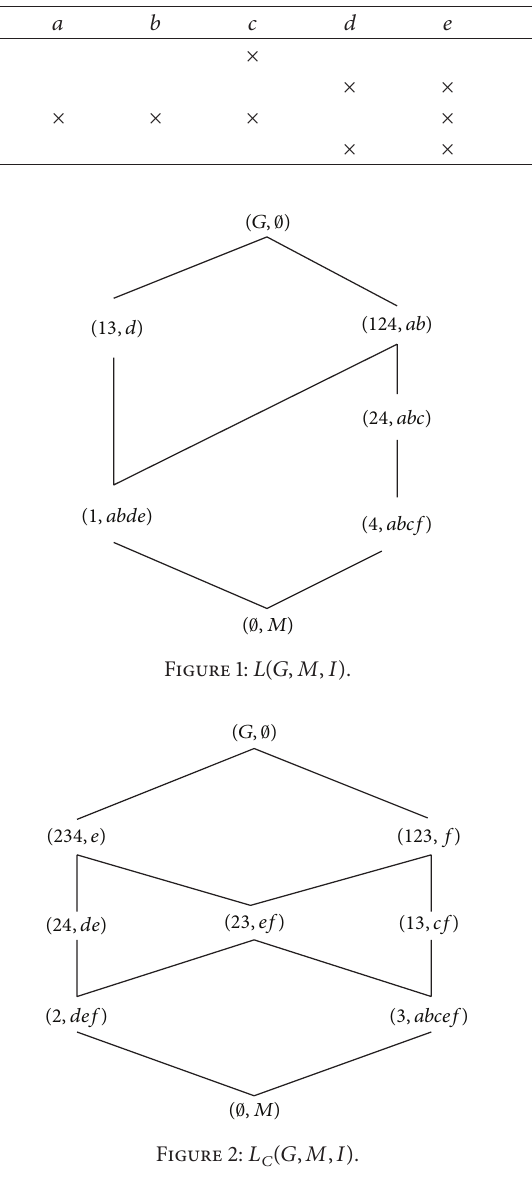
Figure 2: 𝐿 𝐶 (𝐺, 𝑀, 𝐼)